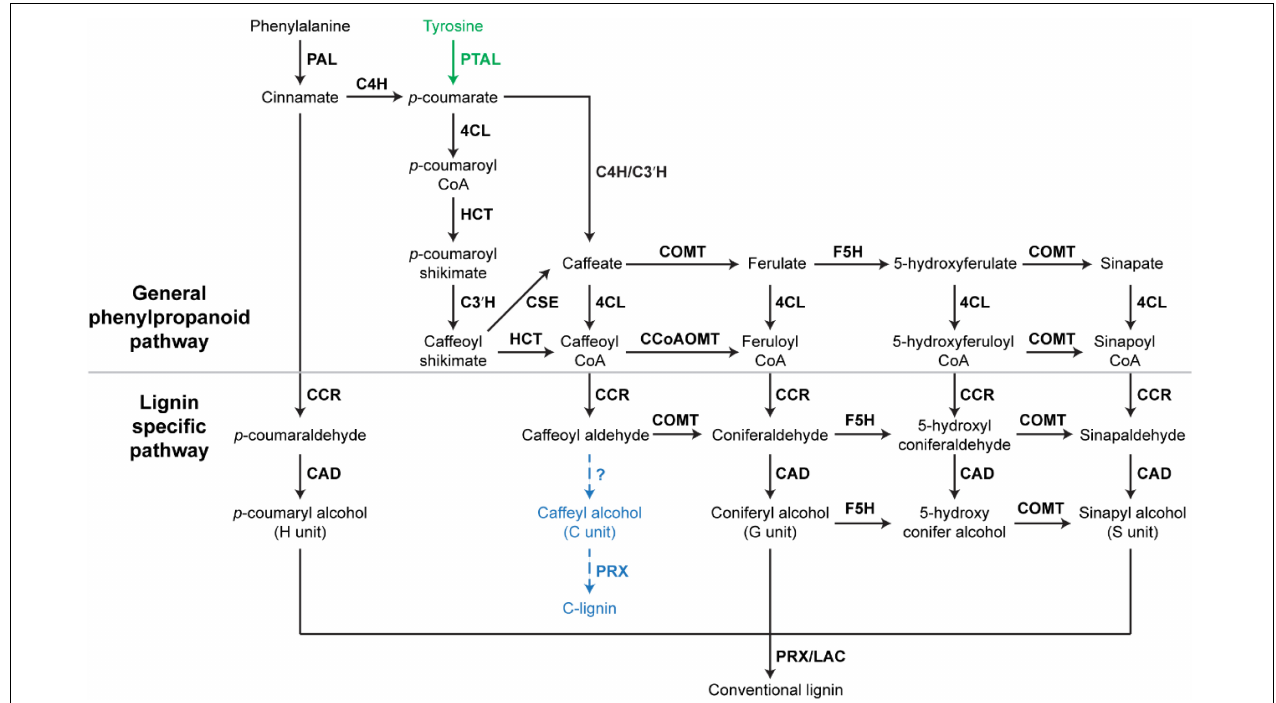
FIGURE 1 | A scheme of lignin biosynthesis in plants. Black arrow indicates the canonical lignin biosynthesis in plants. Green arrow indicates the tyrosine shortcut pathway found in Brachypodium distachyon . Blue dashed arrow indicates the putative C-lignin biosynthesis pathway found in seed coats of vanilla orchid and most Cactoidae genera. Bold font indicates enzymes. PAL, phenylalanine ammonia-lyase; C4H, cinnamate 4-hydroxylase; 4CL, 4-coumarate: CoA ligase; HCT, quinateshikimate p -hydroxycinnamoyltransferase; C3 (cid:48) H, p -coumaroylshikimate 3 (cid:48) -hydroxylase; CCoAOMT, caffeoyl-CoA O -methyltransferase; CCR, cinnamoyl-CoAreductase; F5H, ferulate 5-hydroxylase; CAD, cinnamyl alcohol dehydrogenase; COMT, caffeic acid O -methyltransferase; CSE, caffeoyl shikimate esterase; PRX, peroxidase; LAC,